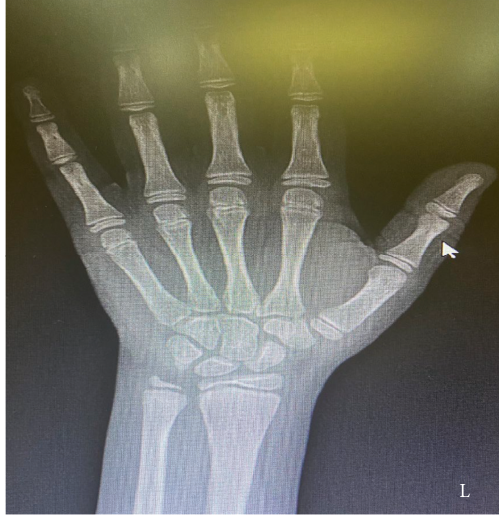
Figure 4: Left wrist X-ray showing a bone age of 10 years in contrast to chronological age of 13.6 years. Bone age was deter- mined using Greulich and Pyle’s radiographic atlas of skeletal development of the hand and wrist